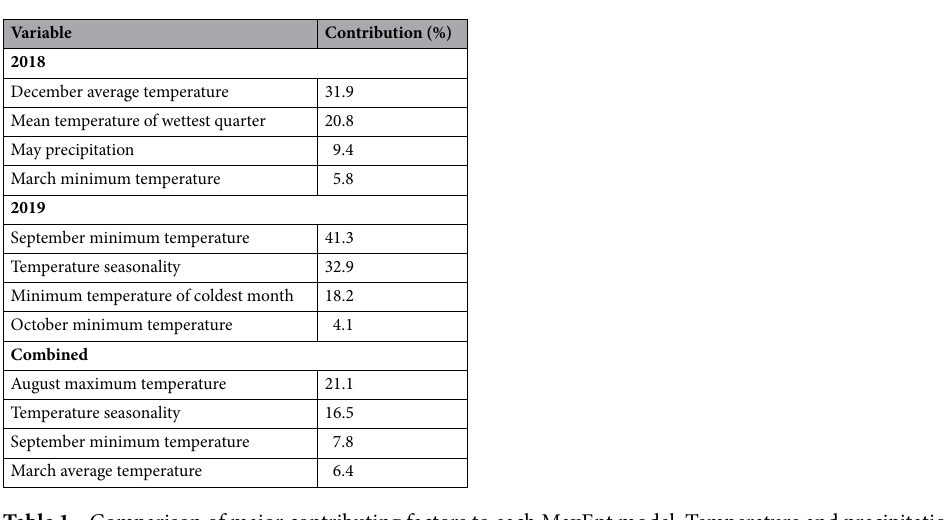
Figure 3. Results from MaxEnt analysis based on collection records from ( A ) only 2018 collecting, ( B ) new locations from 2019, ( C ) combined collecting events (MaxEnt version 3.3.3 k, Adobe, San Jose, CA, USA).